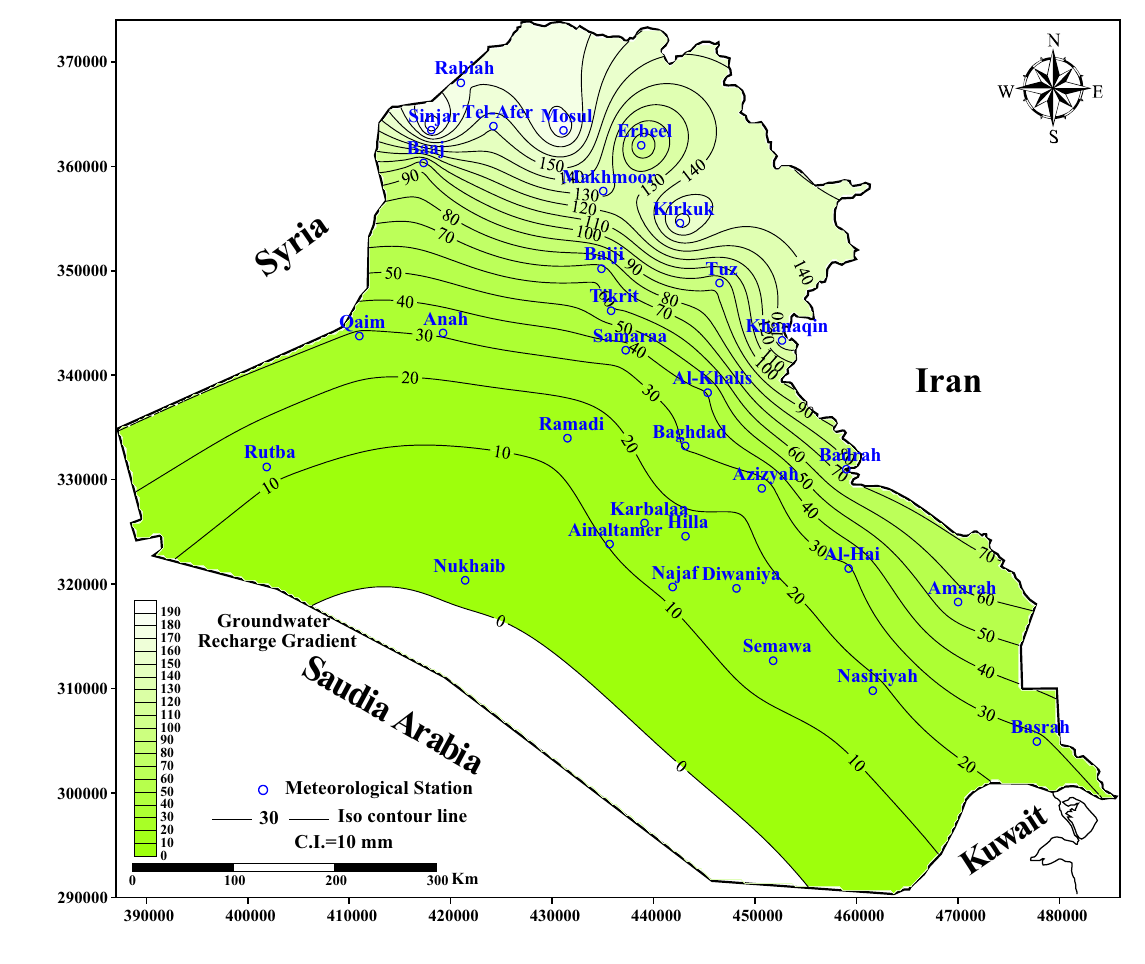
Fig. 7 Contour map of annual groundwater recharge in